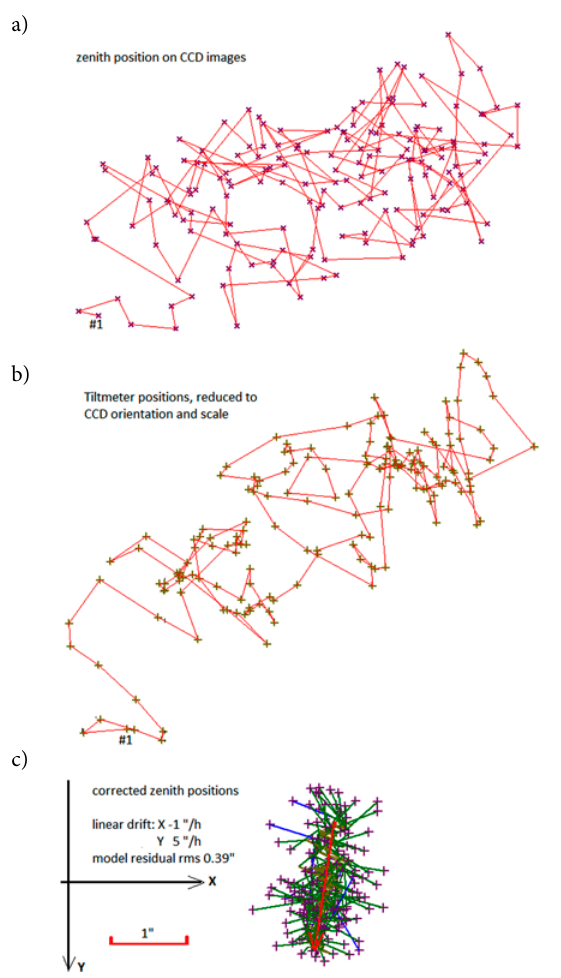
Fig. 6. Static observation session: a) ellipsoidal zenith, b) tiltmeter, c) corrected zenith positions. Consecutive frames connected in a) and b). Model approximation residuals for